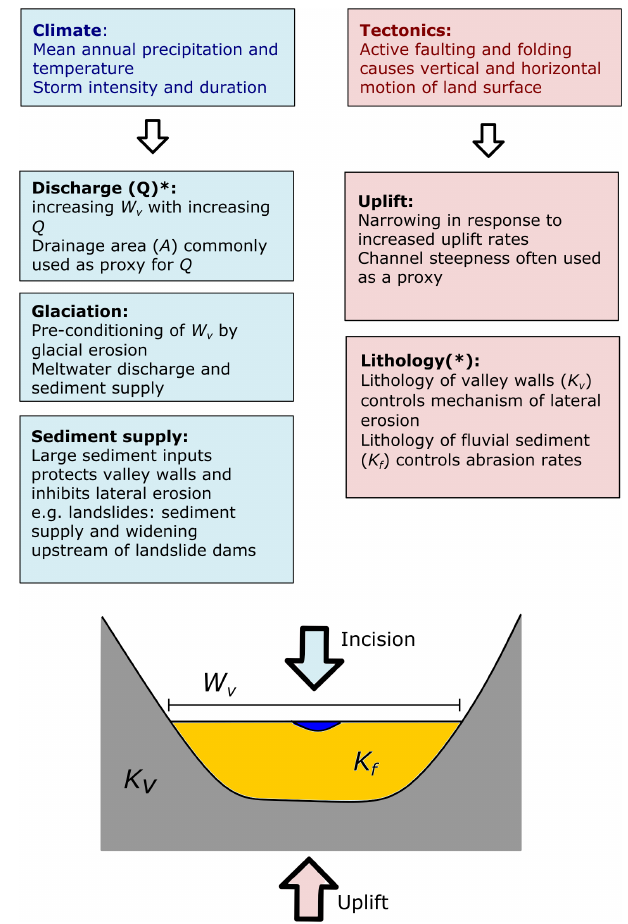
Figure 1. Conceptual model highlighting key controls on valley floor width ( W v ). Climate affects river discharge, sediment supply, and the extent of glaciation within catchments. Tectonics controls uplift rates and lithology by juxtaposing contrasting lithological units. The influence of each factor on valley floor width is high- lighted in the respective box. Factors labelled with an asterisk ( ∗ ) are those included within existing models predicting valley floor